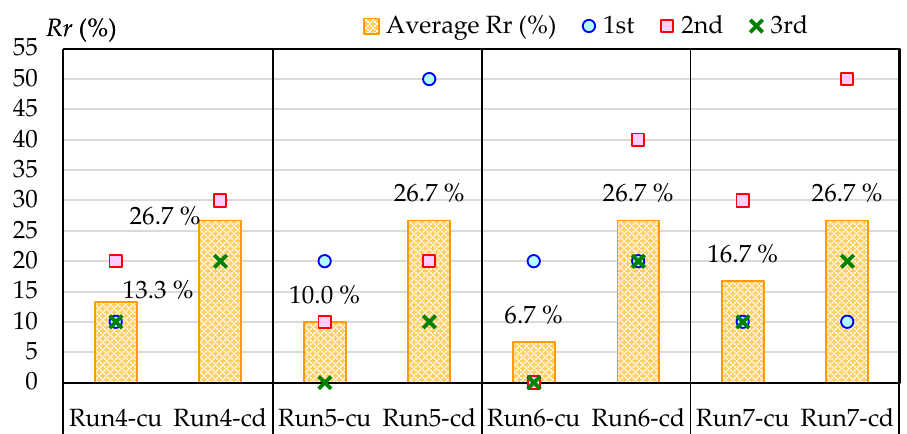
Figure 7. The R r of Ugui in each case (Run4-cu and Run4-cd are previous study [4]).